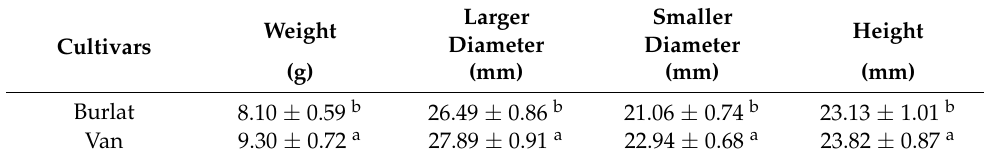
Table 2. Fruit weight (g) and dimensions (mm) of the two sweet cherry cultivars (Van and Burlat).